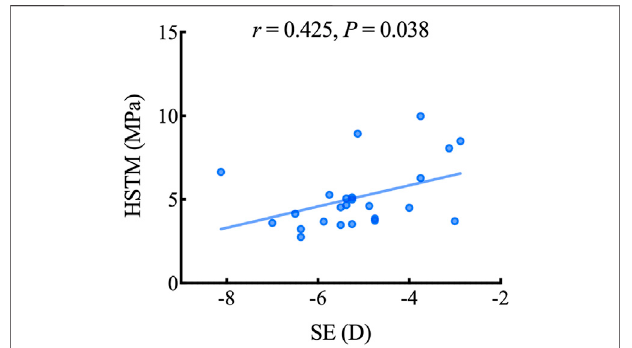
FIGURE5| ScatterplotshowingtherelationshipbetweentheHSTMand SE. HSTM, high strain tangent modulus; SE, spherical